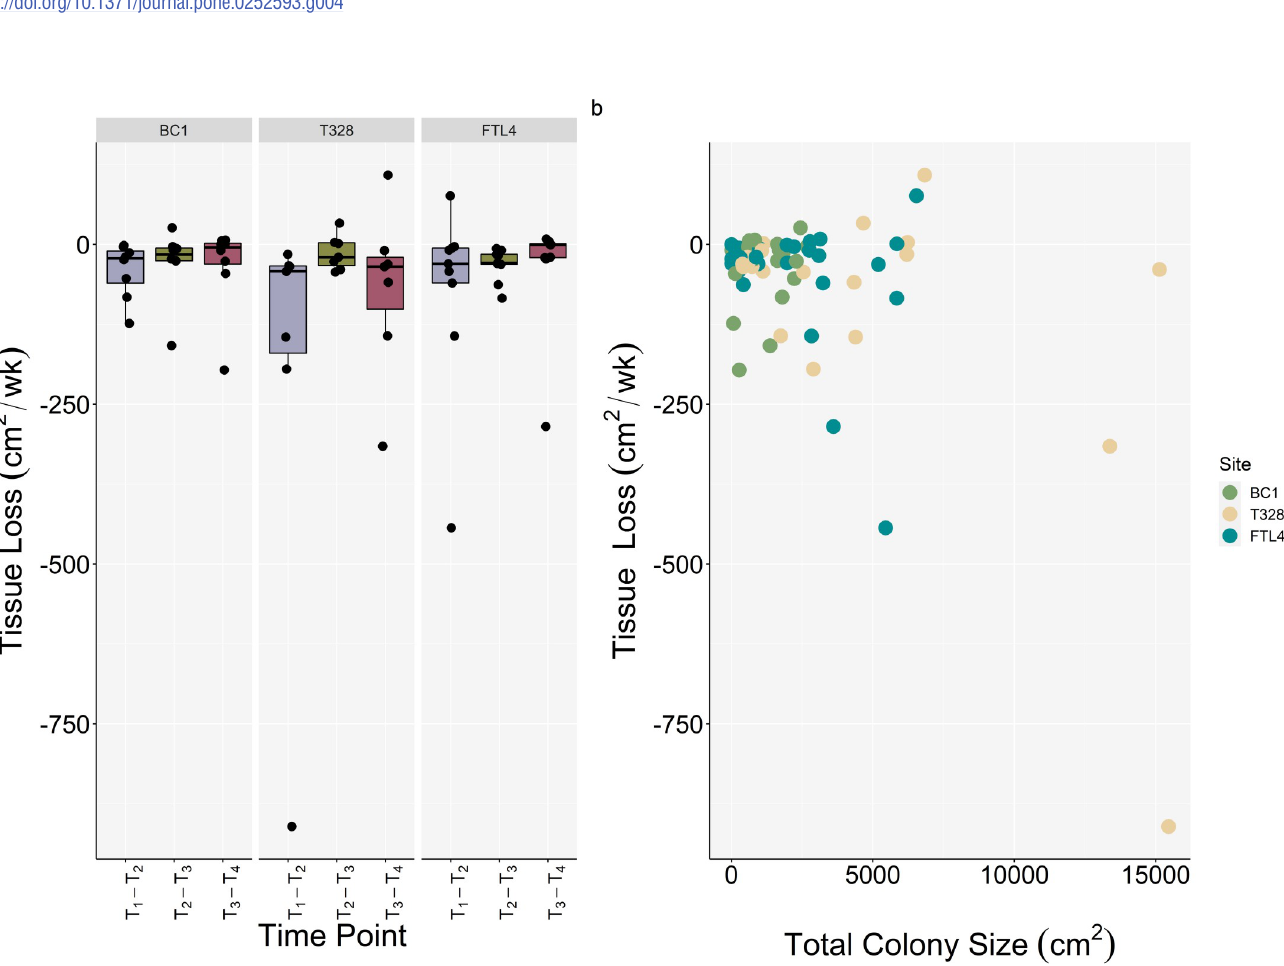
Fig 5. Comparison of rates of tissue loss. (a) Mean change in tissue area on fate-tracked M . cavernosa colonies and (b) Spearman’s rank correlation between rate of tissue loss (cm 2 wk -1 ) and total colony area (cm 2 ).